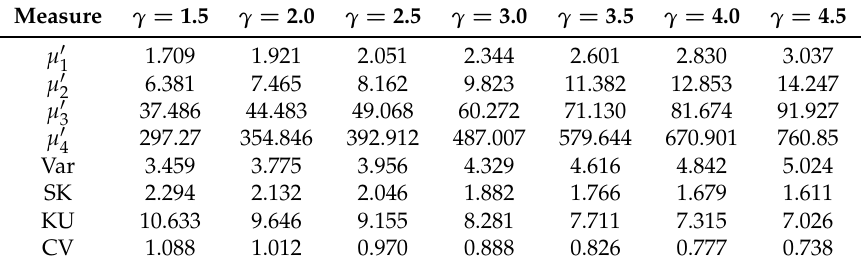
Table 1. Numerical values of some moments, variance, skewness (SK), kurtosis (KU), and the coefficient of variation (CV) of the EMIEE distribution for some selected values of γ and at α = 0.5 and β = 0.5.